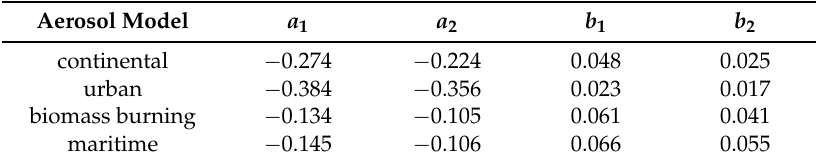
Table 3. The regression coefficients a 1 and a 2 for four aerosol models.